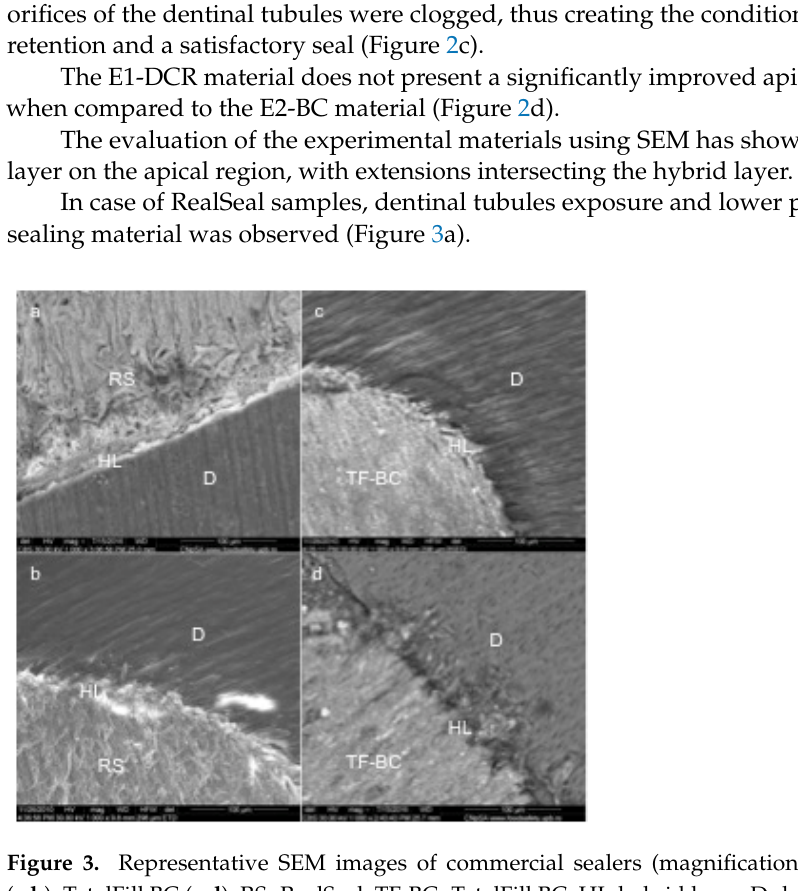
Figure 4. AFM images of sealer/dentin interface: bidimensional- left and tridimensional -right. ( a )- E1-DCR, ( b )-E2-BC, ( c )-RS, ( d )-TF-BC).